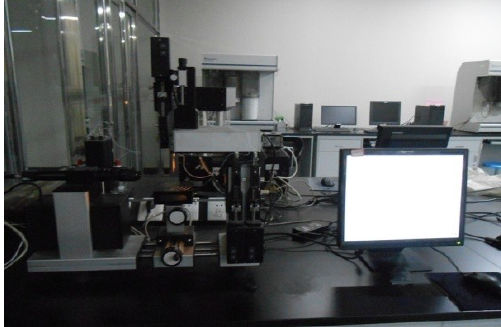
Figure 1. Optical CA measuring device.